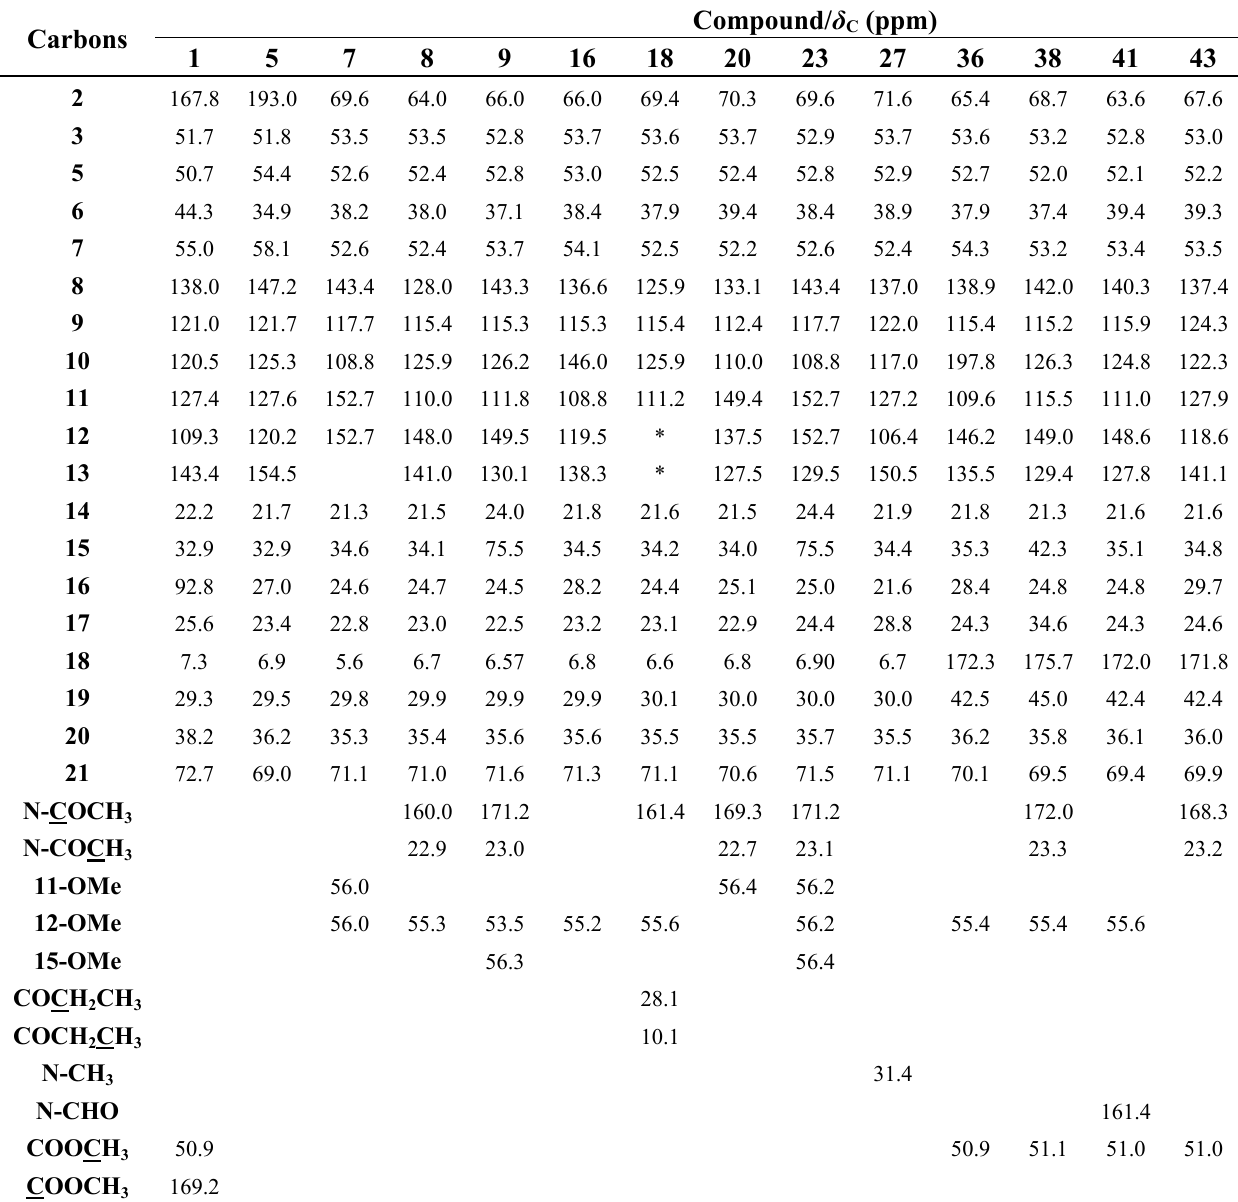
) for the plumeran indole alkaloids from Aspidosperma 3